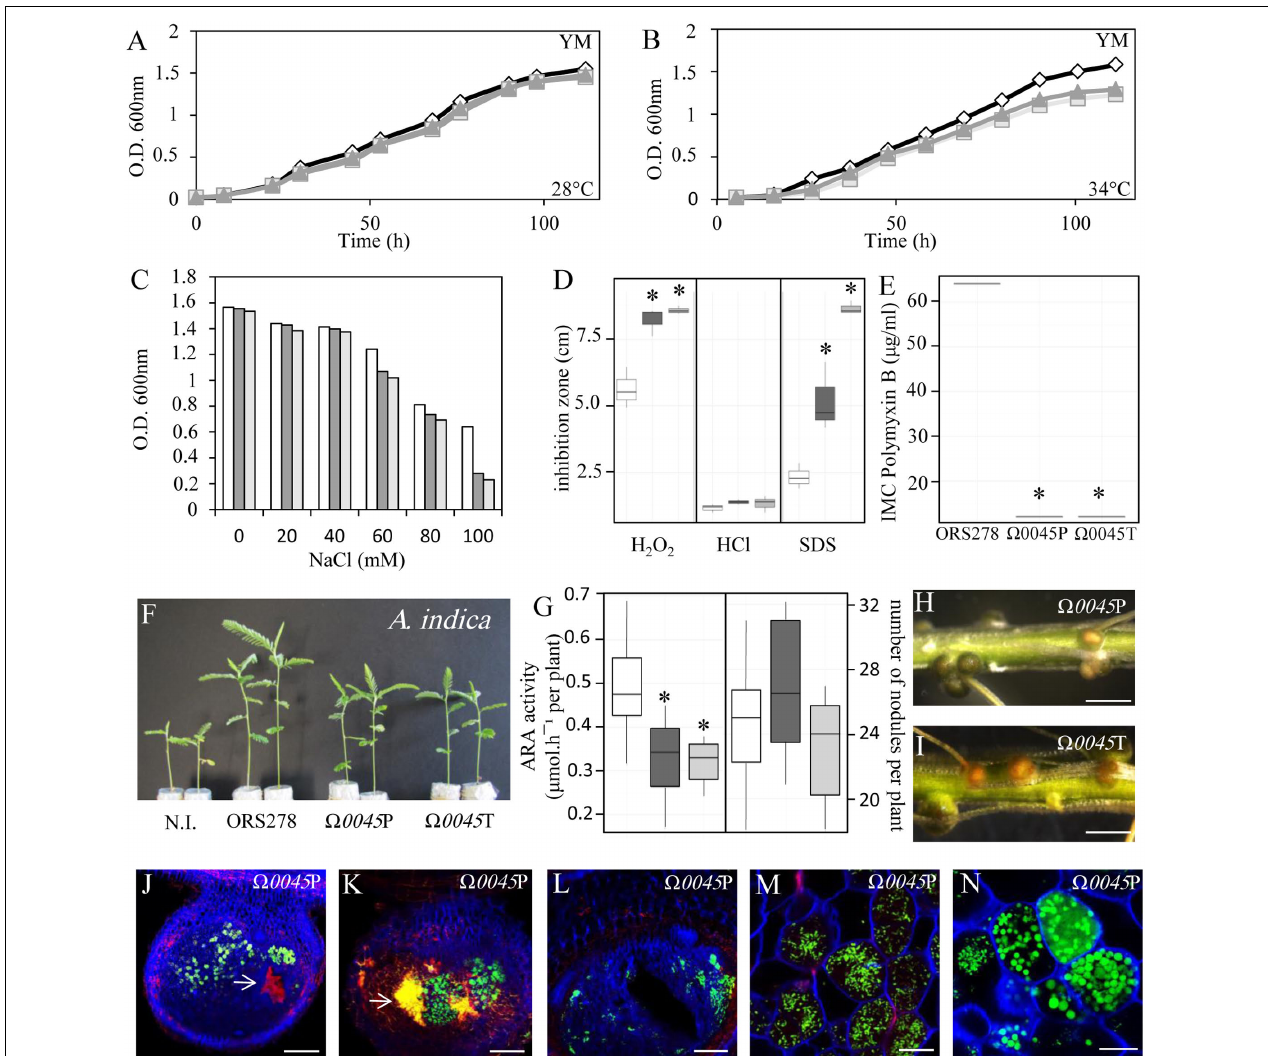
FIGURE 6 | The BRADO0045 mutation affect both free-living and symbiotic states of ORS278. (A–F) Growth of ORS278 (white), (cid:127) 0045 P (dark gray) and (cid:127) 0045 T (gray) mutants in YM medium at 28 ◦ C (A) and 34 ◦ C (B) ( n = 1). (C) NaCl resistance of ORS278 (white), (cid:127) 0045 P (dark gray) and (cid:127) 0045 T (gray) strains cultivated in rich medium (YM), at 34 ◦ C, n = 1. (D) Box plots representation of the Hydrogen peroxide (H 2 O 2 ), hydrogen chloride (HCl) and sodium dodecyl sulfate (SDS) resistance of ORS278 (white), (cid:127) 0045 P (dark gray) and (cid:127) 0045 T (gray) mutants, as determined by disk diffusion assays using 5 µ l of 5.5 M H 2 O 2 , 2N HCl or 10% of SDS ( n = 9). (E) Box plots representation of the Polymyxin B resistance of ORS278 and the two (cid:127) 0045 P and (cid:127) 0045 T mutants, as determined by Etest (Etest R (cid:13) bioMérieux) on YM medium ( n = 3); (F) Comparison of the growth of A. indica (aerial part), non-inoculated (N.I.) or inoculated with ORS278, (cid:127) 0045 P or (cid:127) 0045 T mutants. The experiment was carried out in duplicate with 10 plants per condition. (G) Box plots representation of the quantification of ARA and number of nodules per plant inoculated with ORS278 (white), (cid:127) 0045 P (dark gray) or (cid:127) 0045 T (gray) mutants in A. indica . Whole roots of A. indica inoculed with the (cid:127) 0045 P mutant (H) or the (cid:127) 0045 T mutant of ORS278 (I) ; scale bars: 2 mm. (J–N) Nodule thin sections of A. indica elicited by the (cid:127) 0045 P mutant and viewed by confocal microscopy; scale bars: 300 µ m (J–L) and 20 µ m (M,N) . (J,K) Whites arrows indicate plant defense reactions. (D,E,G) ∗ P < 0.01, by Tukey’s honestly significant difference